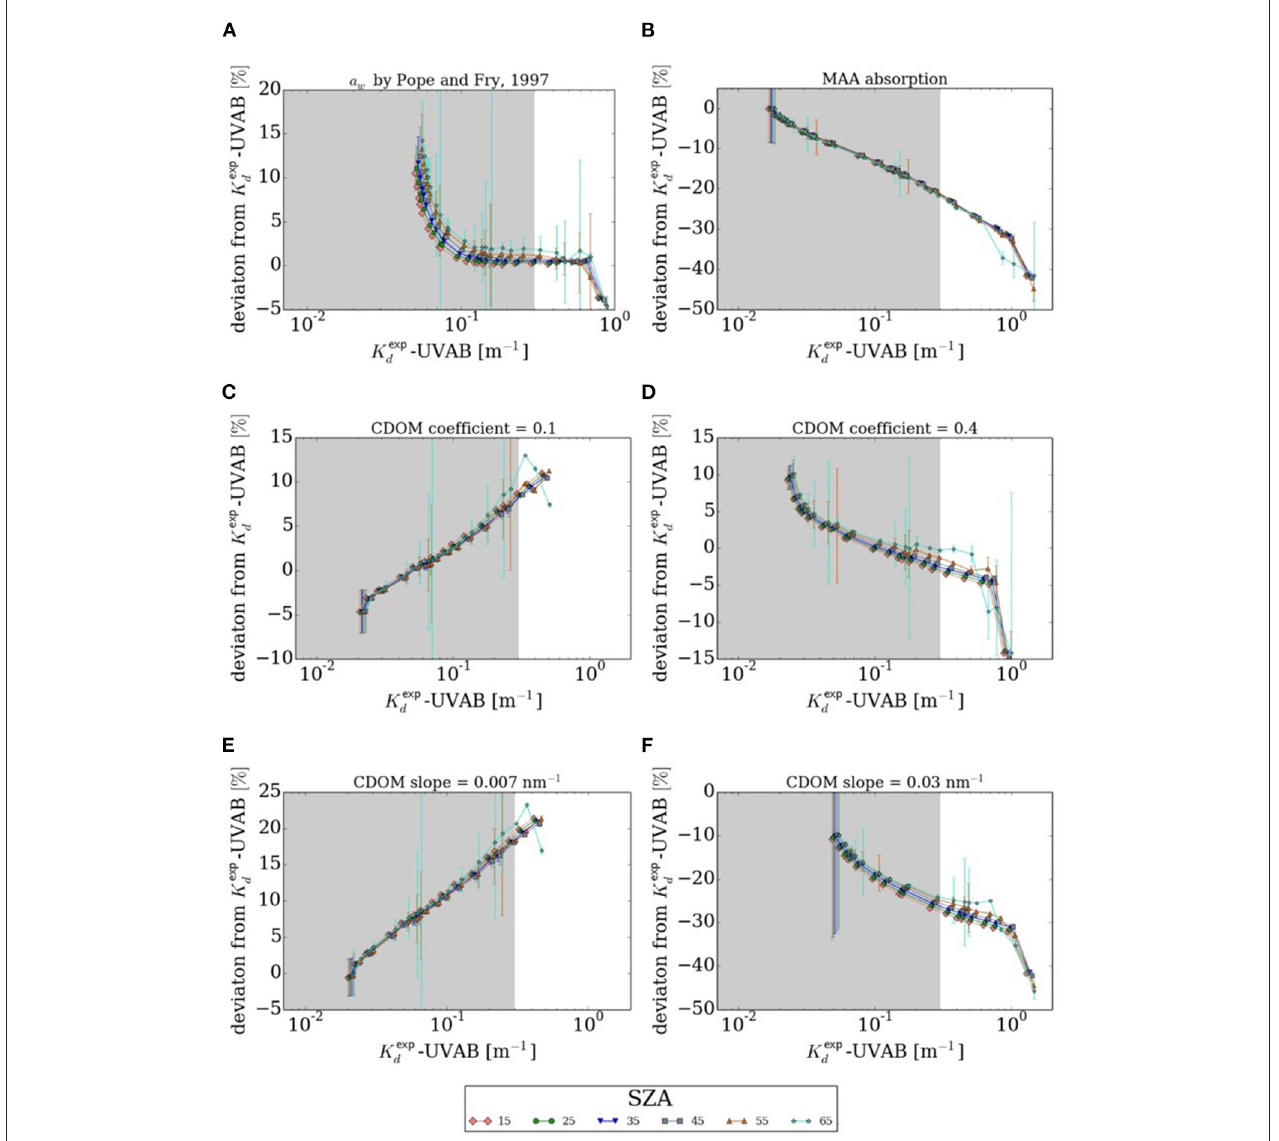
FIGURE 10 | Deviation of derived from expected K d -UVAB in case of (A) liquid water absorption by Pope and Fry (1997), and (B) MAA absorption, (C) reduced and (D) increased CDOM coefficient, (E) reduced and (F) increased CDOM spectral slope as function of expected K d -UVAB. Results were averaged for different VZA with the standard deviation given as error bar.